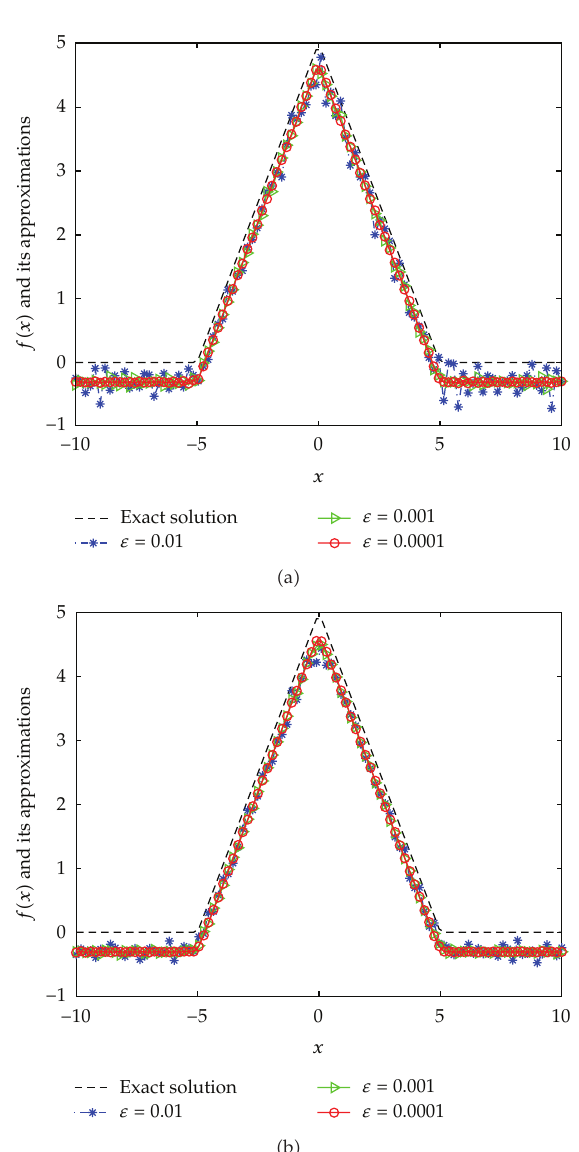
Figure 2: Comparison between the exact solution and its computed approximations with various levels of noise for Example 4.2: (cid:5) a (cid:6) p (cid:7) 1, (cid:5) b (cid:6) p (cid:7)